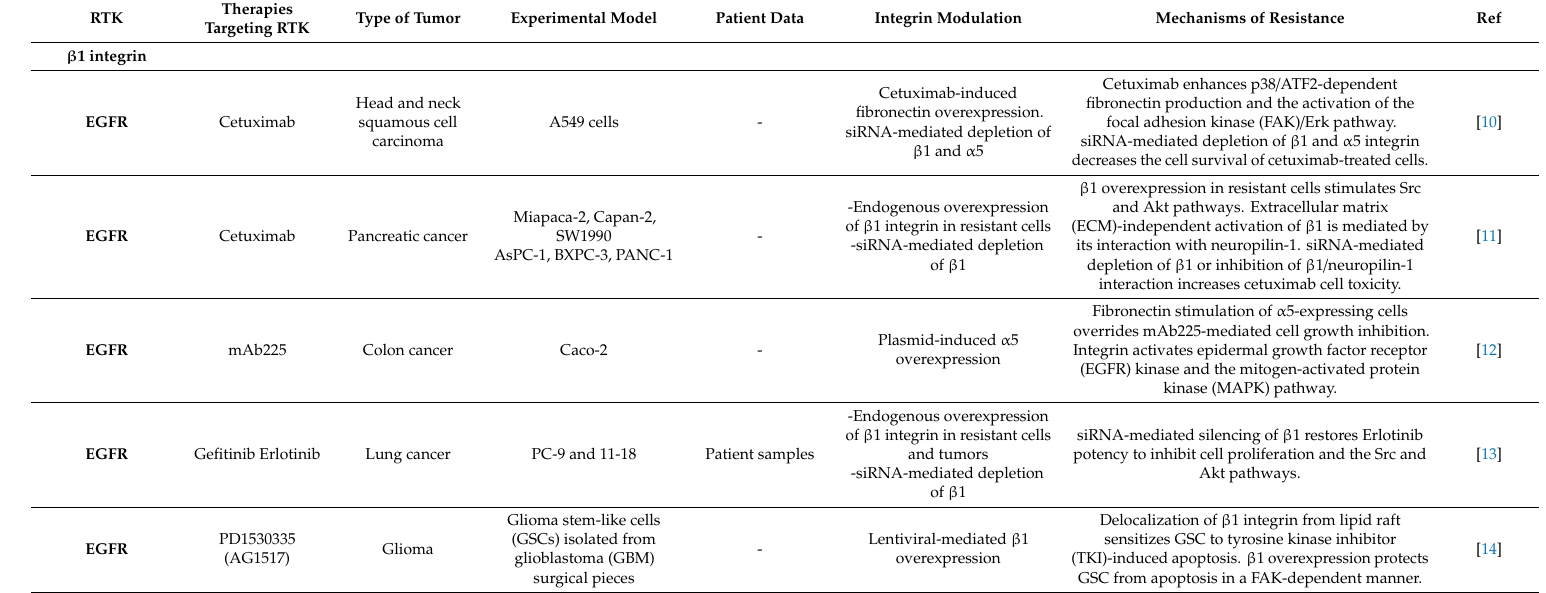
Table 1. Cases of integrin-mediated resistance to RTK-targeted therapies cited in this